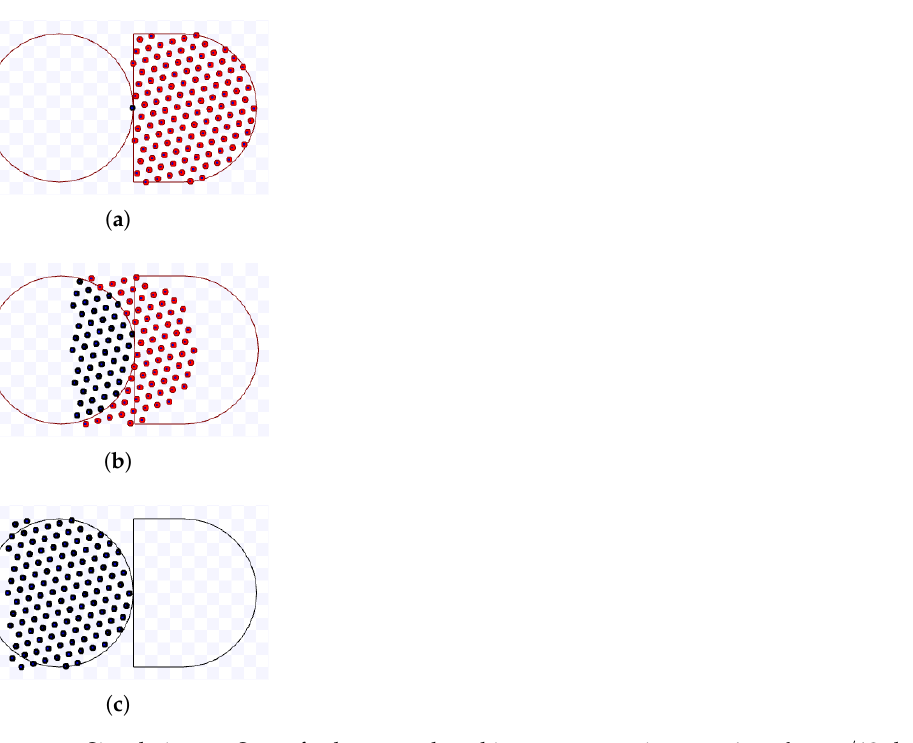
Figure 31. Simulation on Stage for hexagonal packing strategy using s = 6 m, θ = π / 12 during T = 10.1 s. Available on https://youtu.be/OBS_HADH5OE, accessed on 12 June 2022. ( a ) 0 s: beginning of the simulation.; ( b ) After 5 s; ( c ) 10.1 s: ending of the